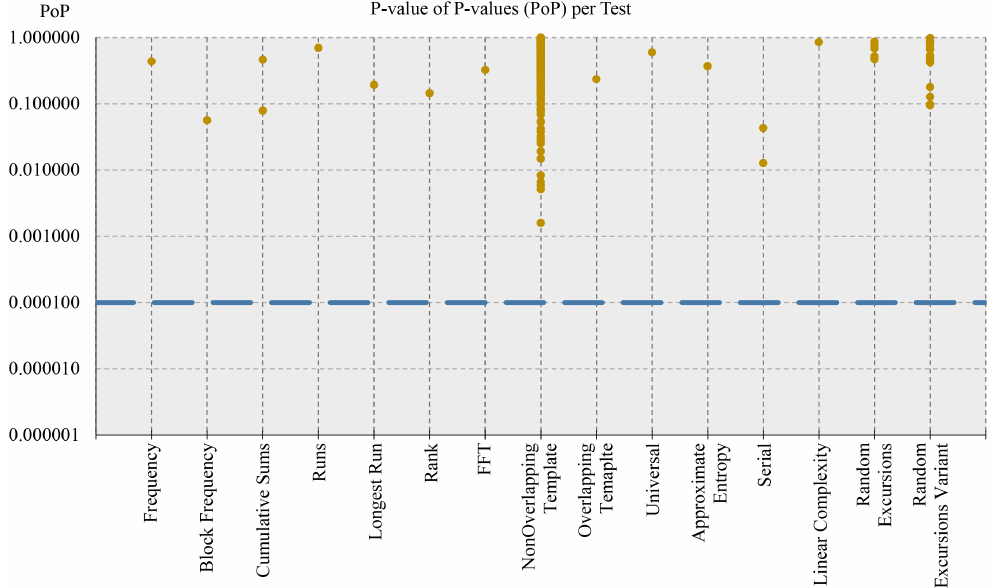
Figure 8. Graph of the results for the PoP metric for the tested DRBG [19,20]. The dark golden points represent the PoP values for each test, and the light-blue dashed line traces the threshold for the pass/fail criterion. The vertical axis is on a logarithmic